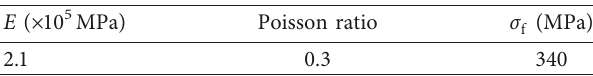
Table 11: The force parameter table of rebar.